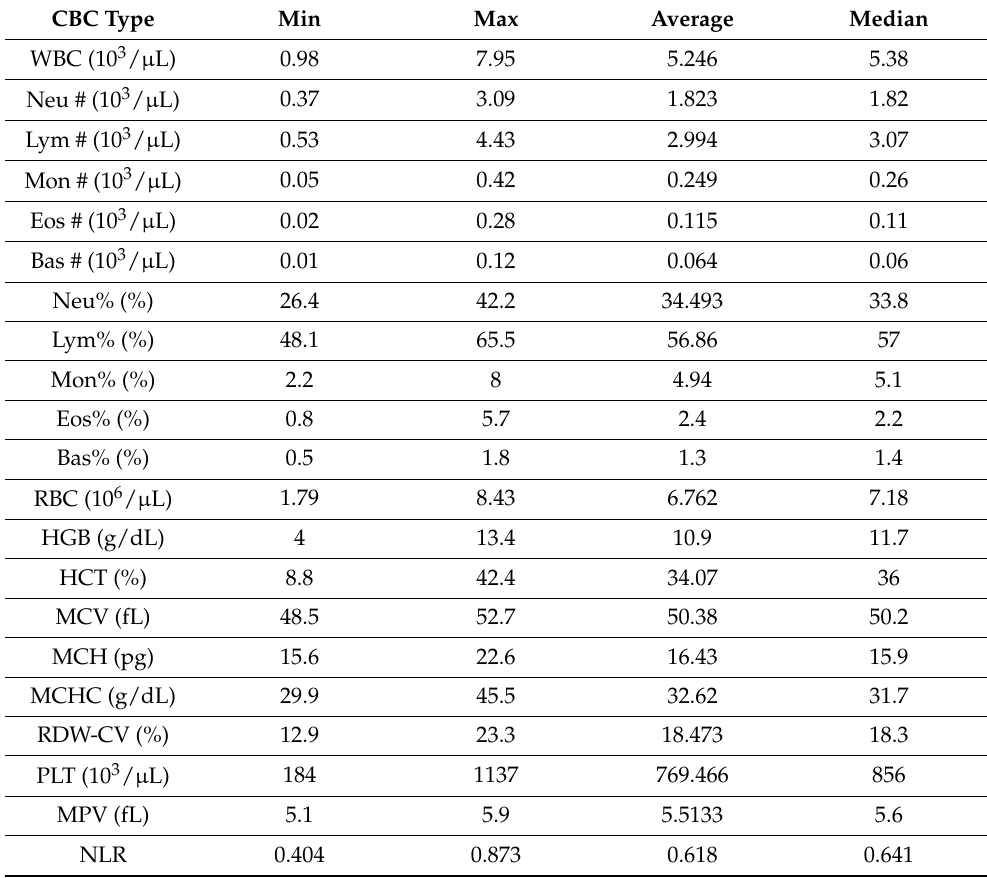
Table 2. Descriptive statistics on the complete blood counts, derived from the blood samples acquired before treatment administration.